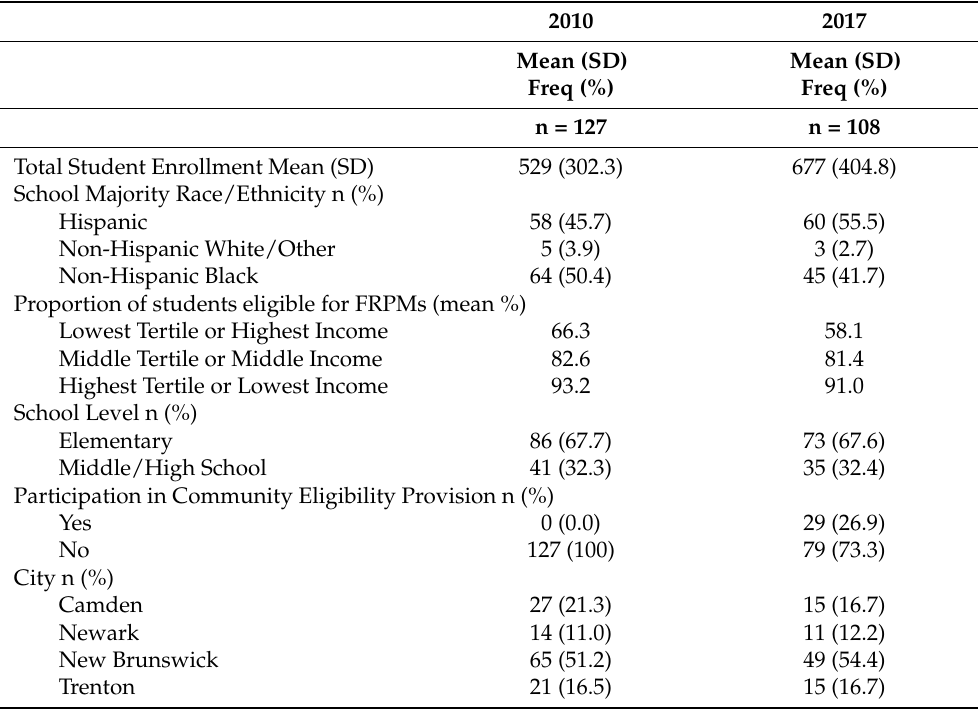
Table 1. Demographic characteristics of public schools from four New Jersey school districts included in the analytical sample in 2010 (baseline) and